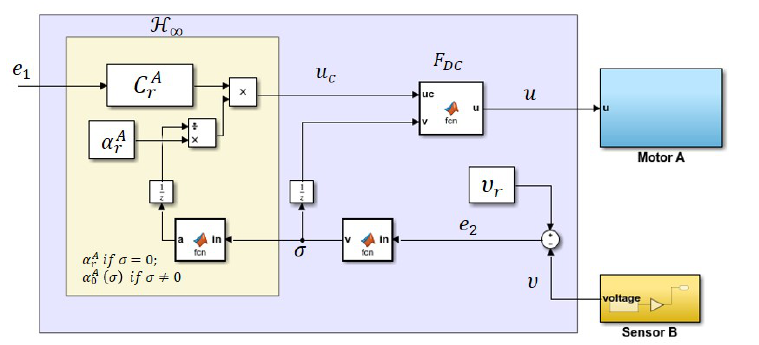
Figure 8. Illustration on the implementation of the proposed controller in the Simulink